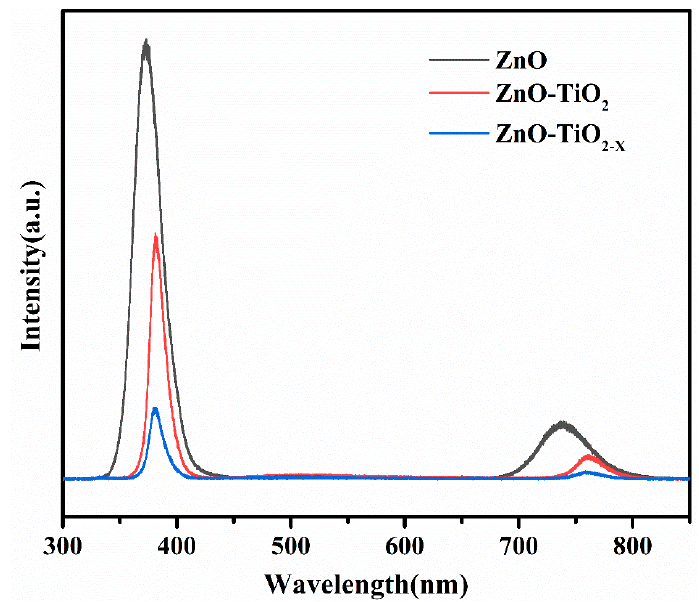
Figure 6. PL spectra of different photoanodes recorded with the excitation wavelength of 325 nm.